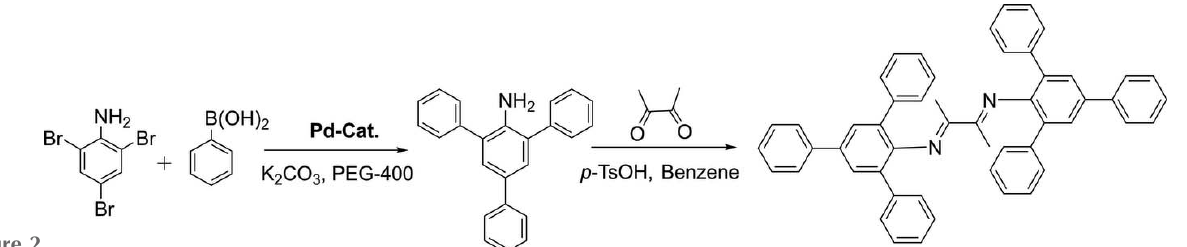
Figure 2 Reaction scheme.